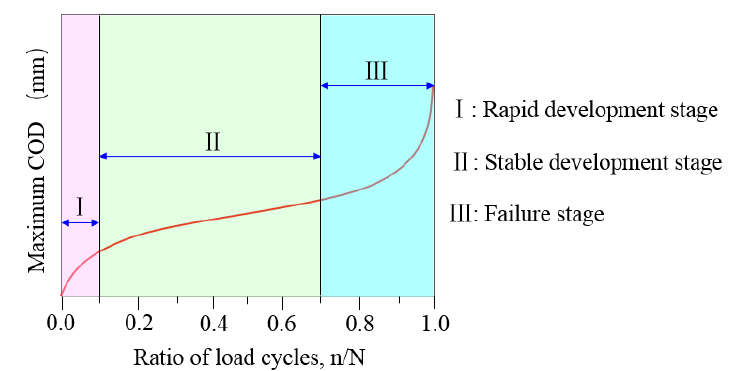
Figure 4. Evolution of Maximum COD with the ratio of load cycles.